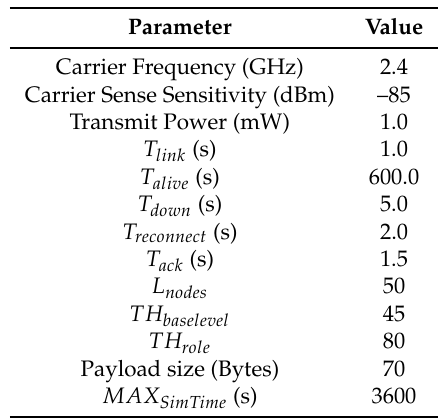
Table 1. Most relevant configuration parameters for the